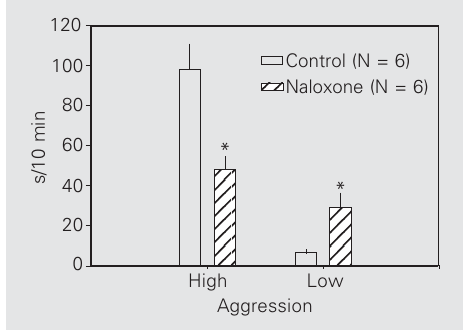
Figure 1. Effects of naloxone (1 mg/kg) on total time spent in of- fensive aggression by high and low aggression pigeons. Data are reported as means ± SEM. High = high aggression; Low